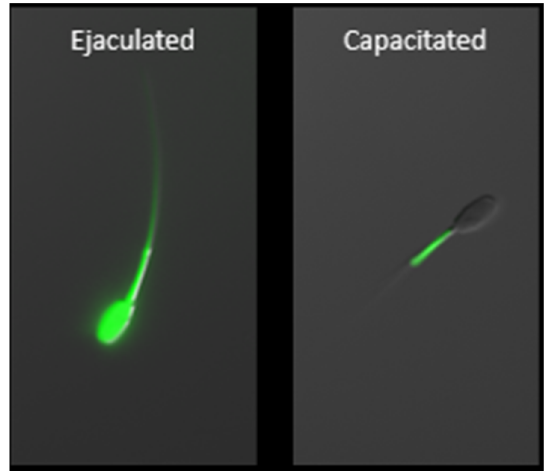
Figure 3. Zinc localization in boar ejaculated and capacitated spermatozoa using fluorescent probe FluoZin TM -3, AM. Capacitation-related efflux of zinc ions from the sperm head and principal piece is a prerequisite for achieving capacitated, hyperactivated status. Following capacitation, zinc is lo-calized exclusively within the mitochondrial sheath where it is functional, thus indicative of the importance of zinc homeostasis in the sperm mitochondria. The scale bar represents 10 µm.